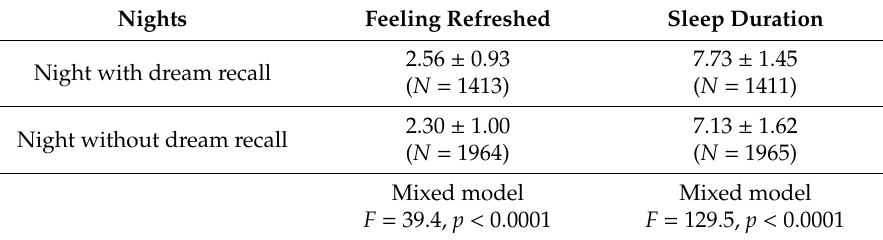
Table 1. Feeling of being refreshed and sleep duration after nights with dream recall compared with nights without dream